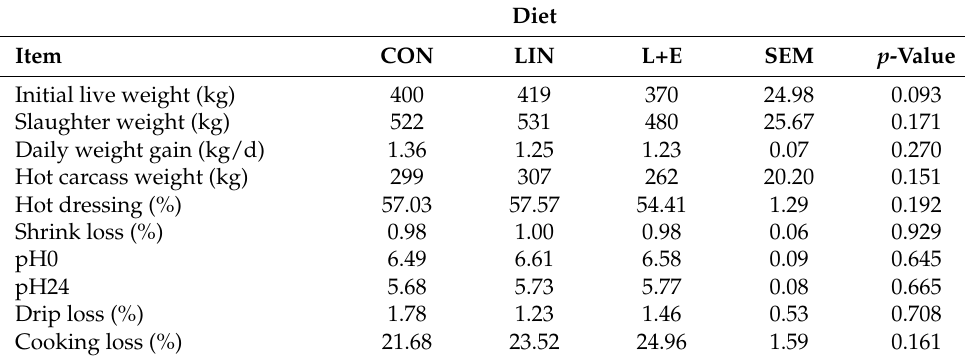
Table 2. Performance and slaughter traits of the 18 Charolaise × Podolica young bulls (mean values) after 91 ± 18 days on feed.